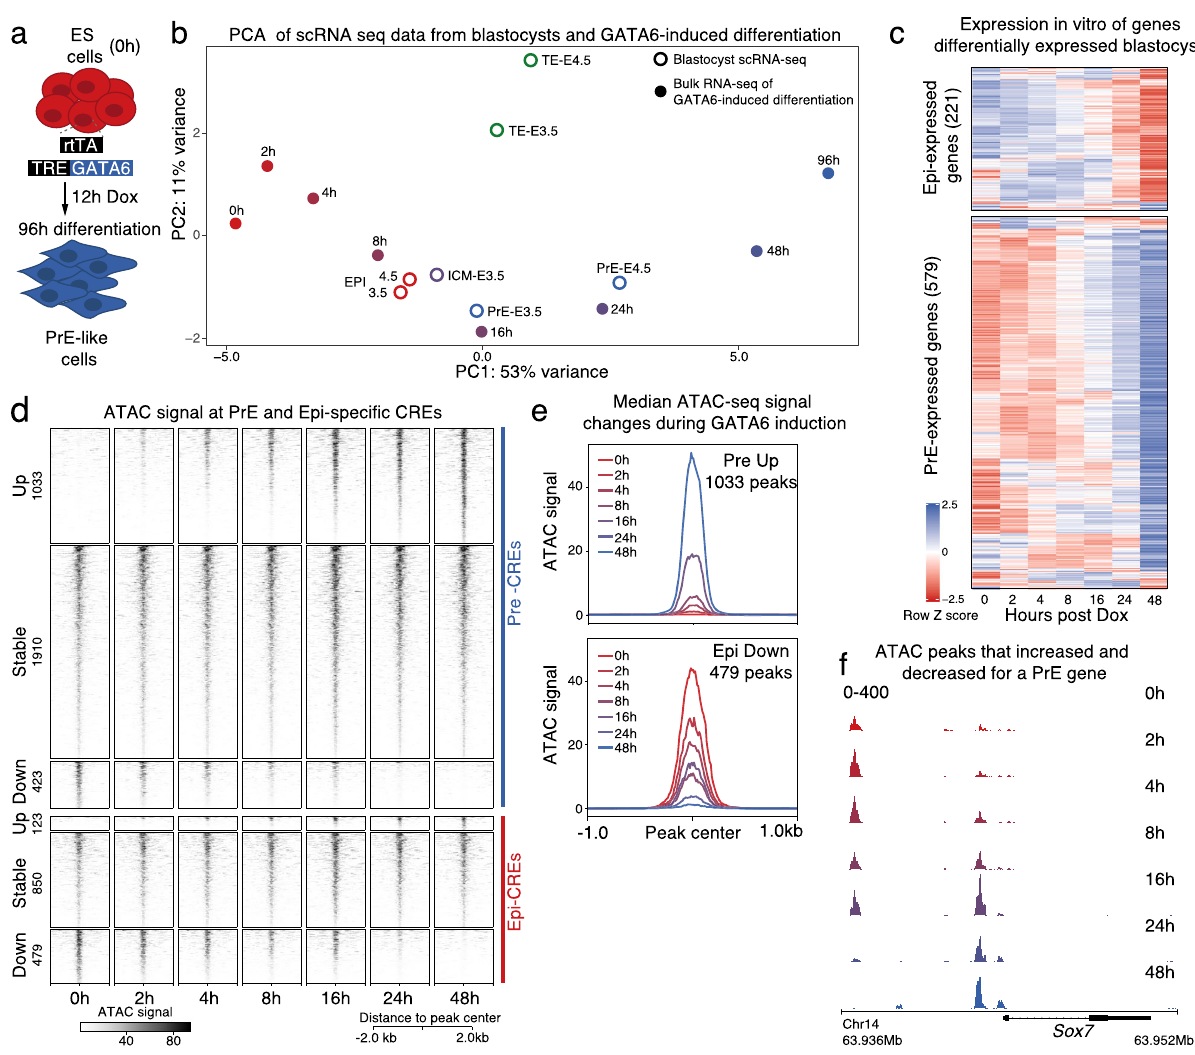
Fig. 1 GATA6-driven in vitro differentiation recapitulates PrE speci fi cation in blastocysts and initiates rapid transcriptional changes and chromatin remodeling. a Scheme depicting GATA6-driven in vitro differentiation of mES cells used to study PrE speci fi cation. b PCA of bulk-RNA-seq at differentiation time-points (solid circles) and single-cell RNA-seq pro fi les of E3.5 and E4.5 blastocysts (open circles). The PrE precursor state was achieved by 16 h of GATA6-driven differentiation and fully speci fi ed PrE-cells appeared at 24-48 h. c Heatmap of transcript z -scores of Epi- and PrE-speci fi c genes shows that most blastocyst lineage-speci fi c genes showed similar changes in expression during GATA6-driven differentiation. d Changes in chromatin accessibility measured by ATAC-seq at PrE and Epi CREs were quickly initiated within 2 h of differentiation. Accessible regions at 48 h were compared to 0 h and classi fi ed as up, stable or down. e Median ATAC signal plots depict an increase in ATAC signal at 1033 PrE-CREs and decrease at 479 Epi-Cres. f Browser view at the Sox7 locus showing a progressive loss in ATAC signal at a distal CRE and a gain in accessibility at a proximal CRE. This example shows that not all PrE CREs gained accessibility during PrE-speci fi